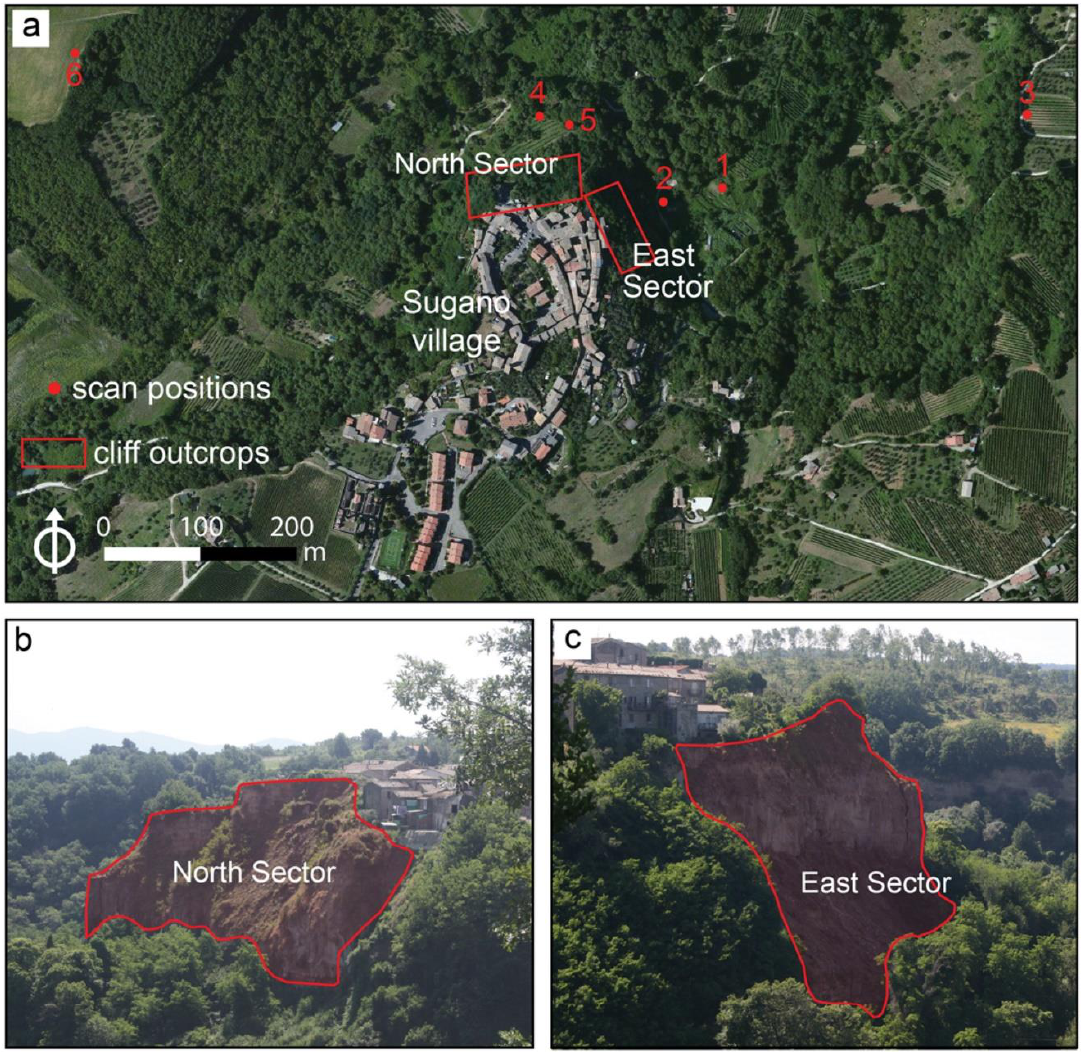
Figure 3. Satellite image ( a ) and pictures of the north ( b ) and east ( c ) sectors of the Sugano cliff. The location of the six scan positions is also reported. Image in ( a ) is extracted from Google Earth Pro ® Version 7.3.2. (2018). Retrieved from https://www.google.com/earth/download/gep/agree.html